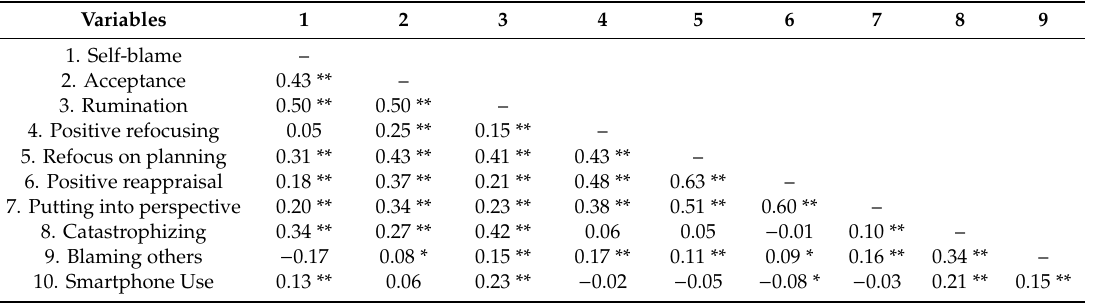
Table 3. Pearson correlation coe ffi cients ranged from − 0.01 to 0.63. In general, these results showed small to moderate correlations between the strategies. Table 3. Pearson intercorrelations between Cognitive Emotion Regulation strategies subscales and excessive smartphone